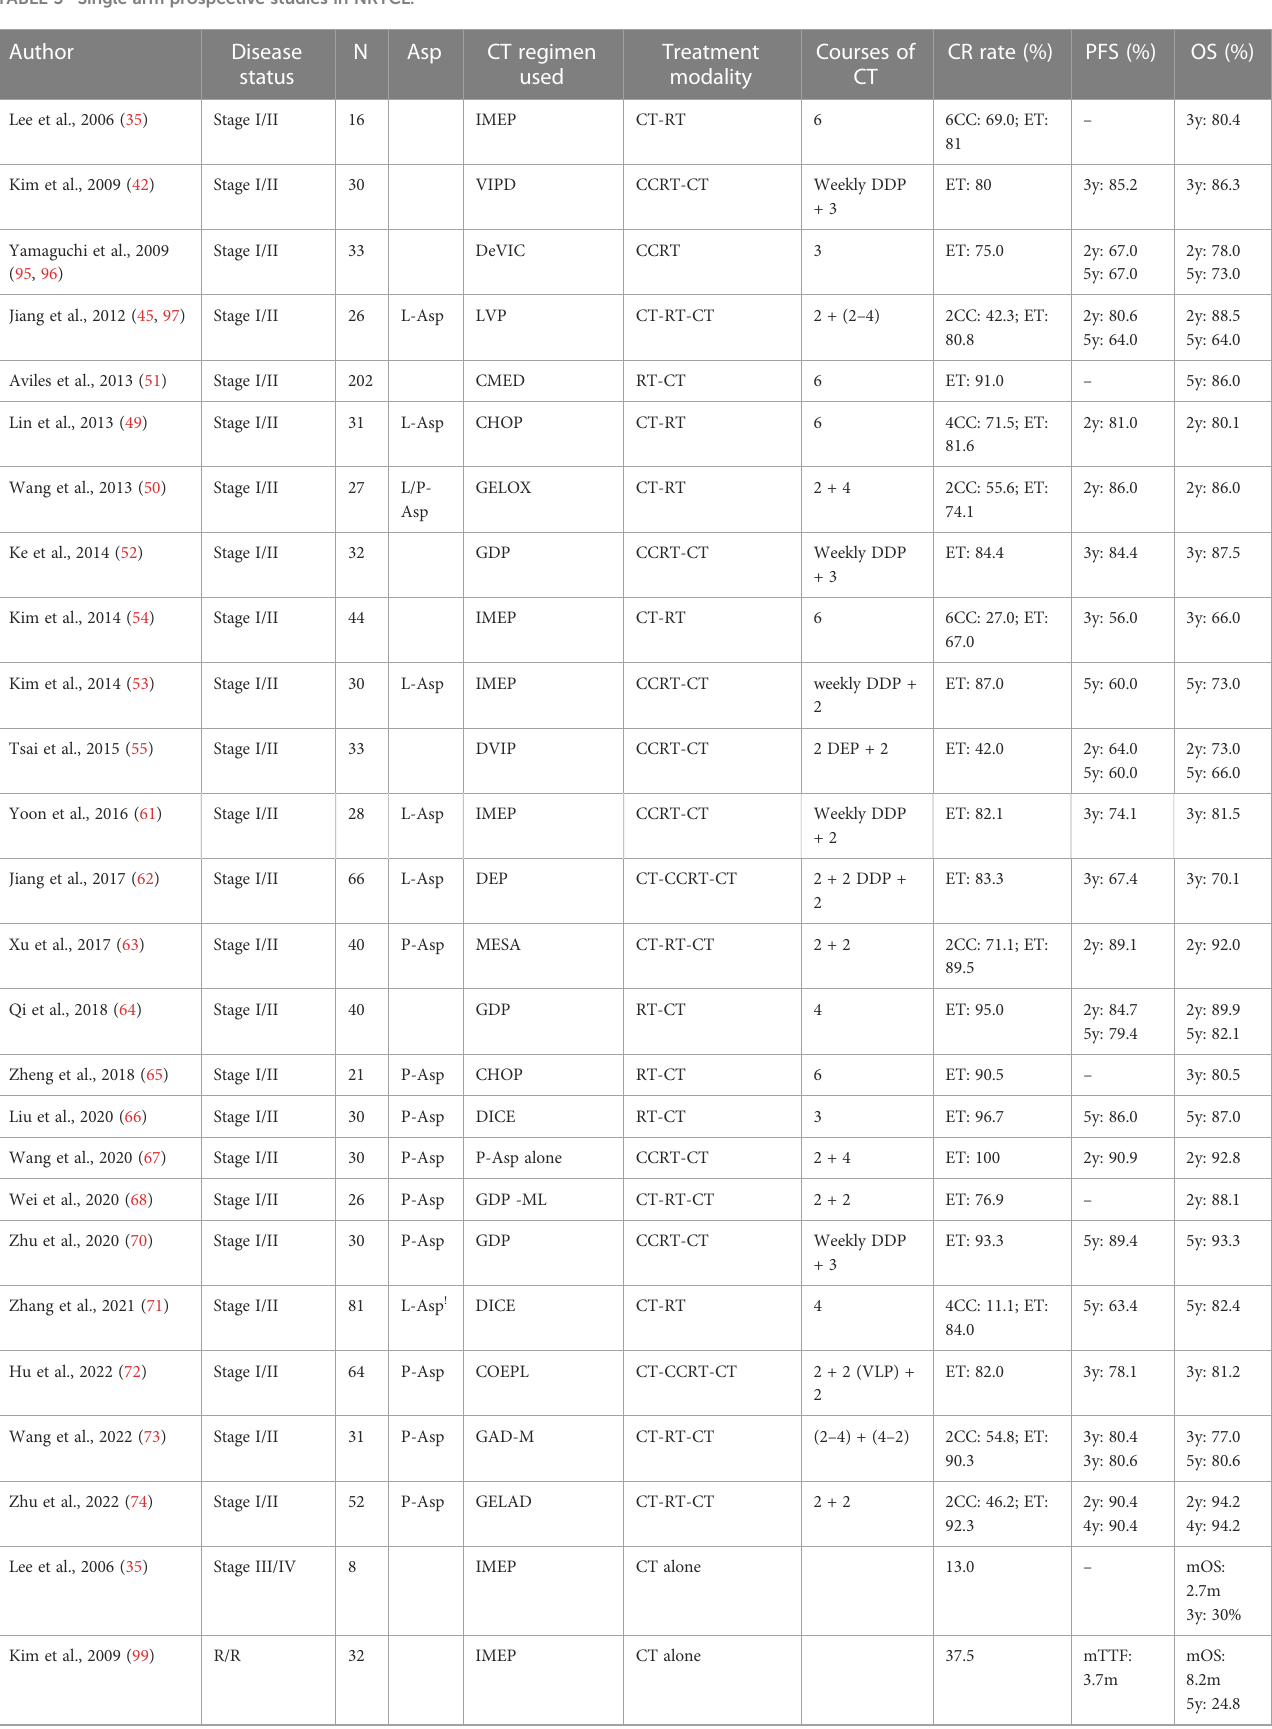
TABLE 3 Single arm prospective studies in